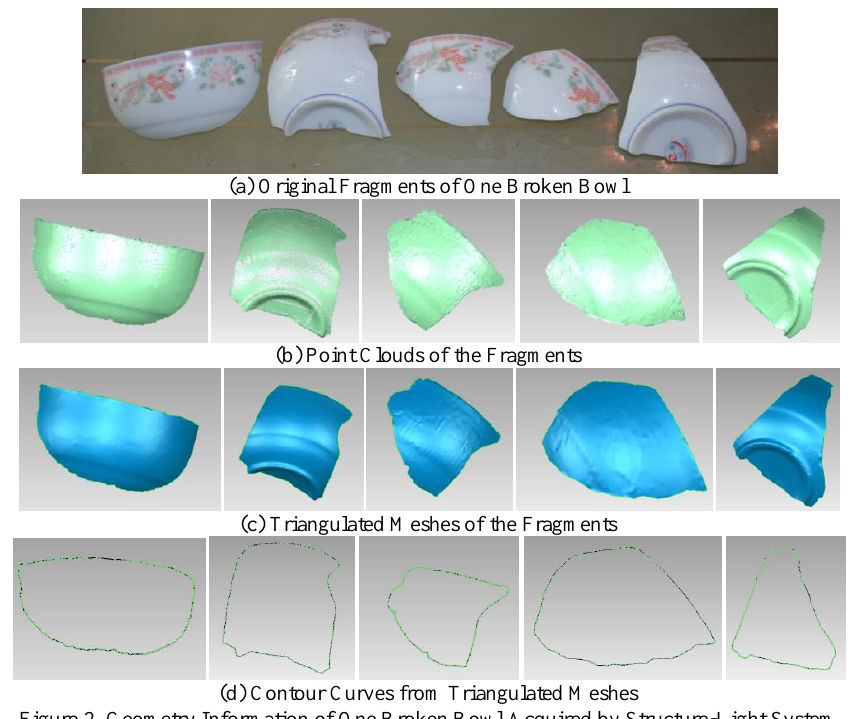
Figure 2. Geometry Information of One Broken Bowl Acquired by Structure-Light System